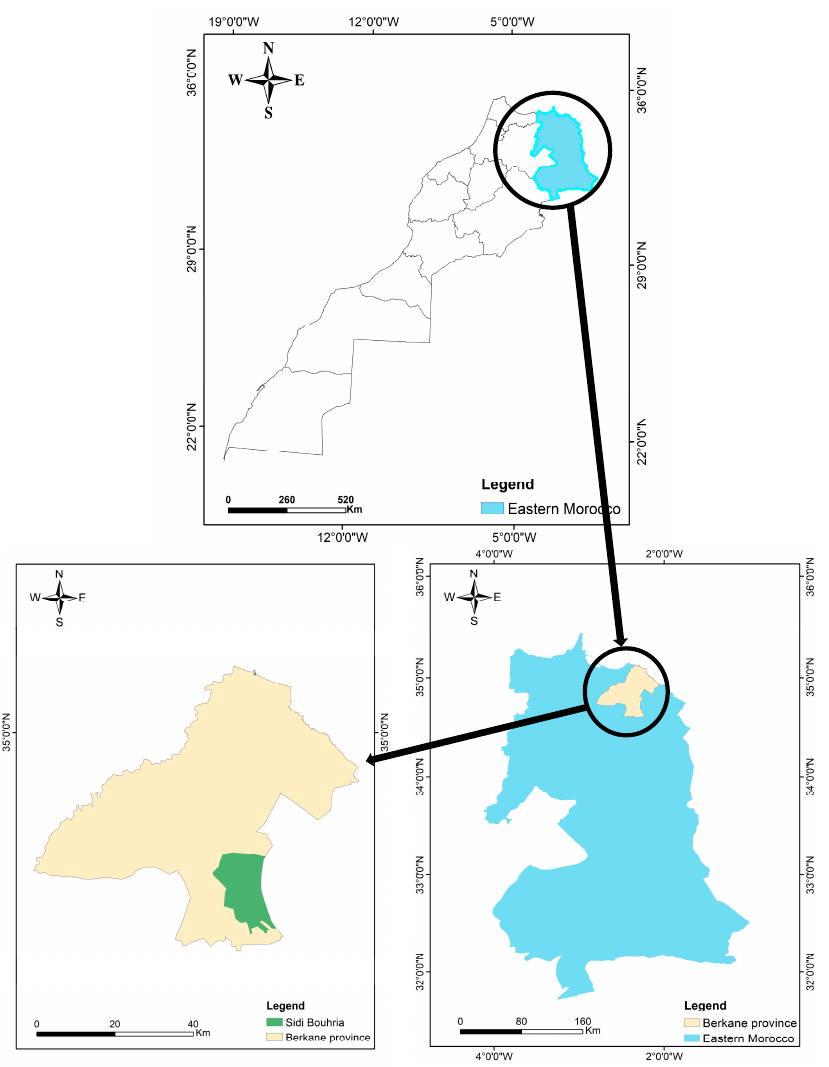
Figure 1. Location of the sampling site (Sidi Bouhria eastern region of Morocco).